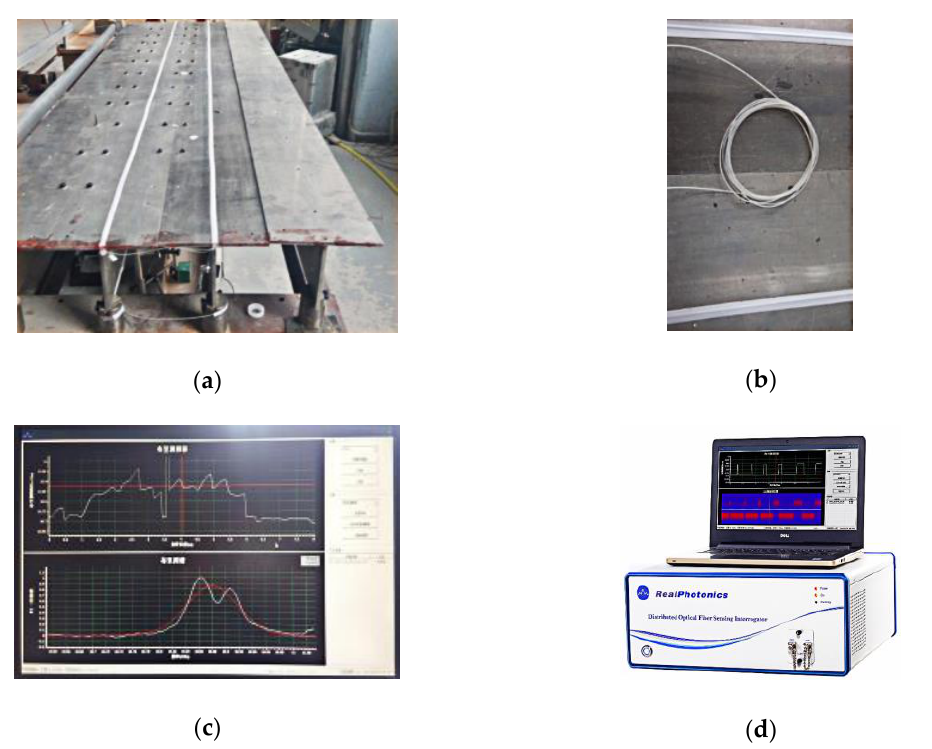
Figure 17. Photographs of the sensing system: ( a ) placement of the optical fiber; ( b ) optical fiber; ( c ) software interface of the fiber optic demodulator; ( d ) fiber-optical demodulator.